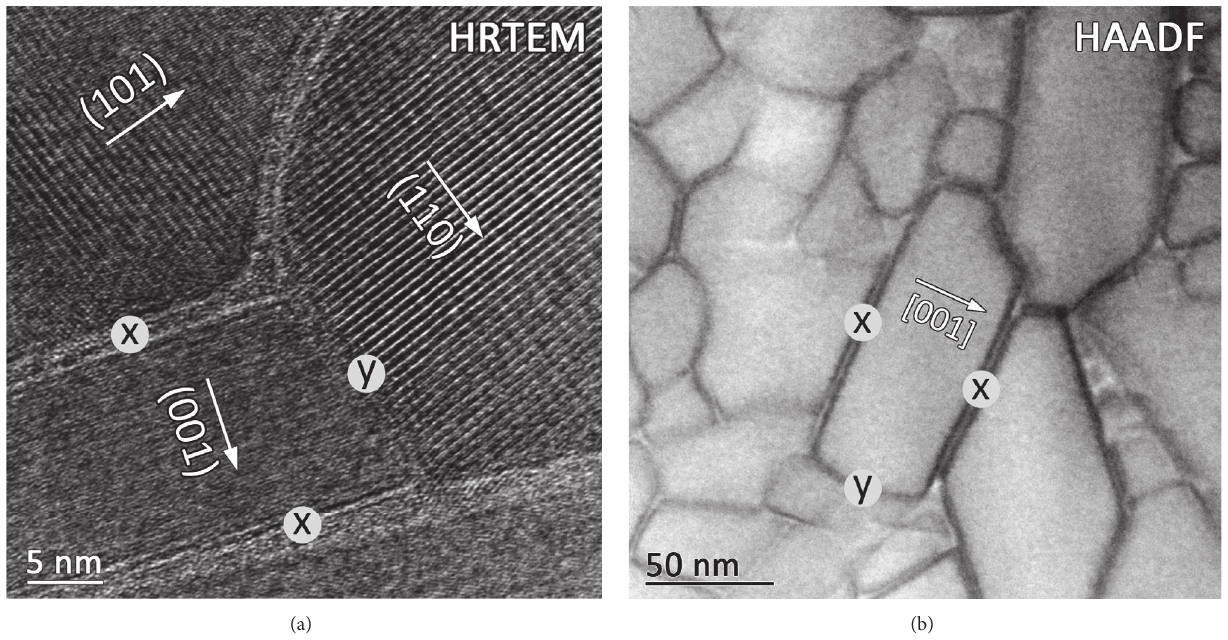
Figure 8: (a) HRTEM image of four Nd-Fe-B grains separated by 𝑥 -, 𝑦 -, and 𝑧 -GBs, (101), (110), and (001) lattice fringes of the grains are visible. (b) HAADF image of the grain, from which the EELS line scans of Figure 9 were taken.